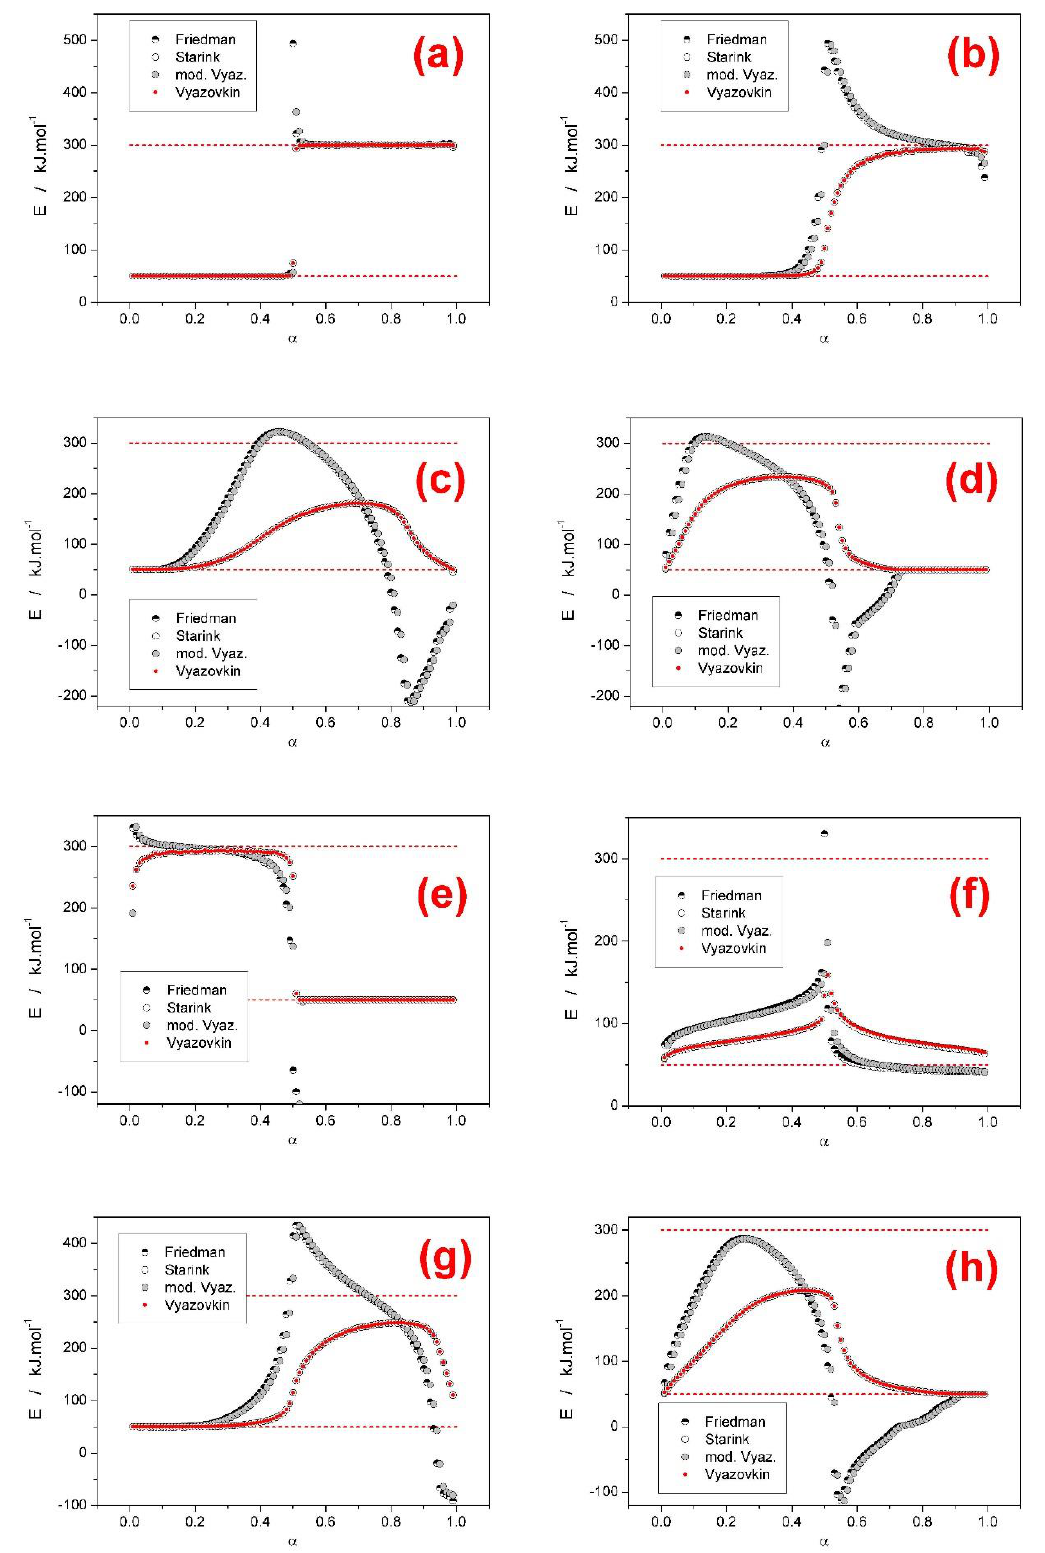
Figure 6. Results of the Friedman, Starink, Vyazovkin and modified incremental Vyazovkin analyses applied to the datasets A–H (group 2) and the I 1 = I 2 = 0.50 simulated at 10,000 points / curve density. The horizontal red dashed lines in each graph represent the true E 1 and E 2 values input into the simulations. ( a ) set A; ( b ) set B; ( c ) set C; ( d ) set D; ( e ) set E; ( f ) set F; ( g ) set G; ( h ) set H.